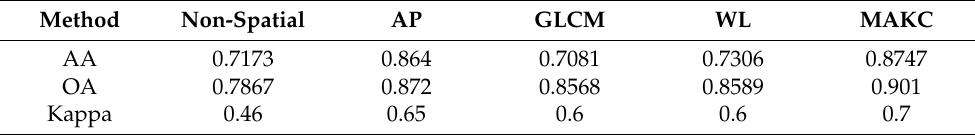
Figure 8. Classification result (in OA, AA, and Kappa) comparison between MAKC and MAKC without spatial information, with different numbers of training samples. This is demonstrated on ( a ) SAR1 image, ( b ) SAR2 image, and ( c ) SAR3 image. TN = n means the number of training samples is equal to n. Table 6. Classification results on SAR1 with TN =